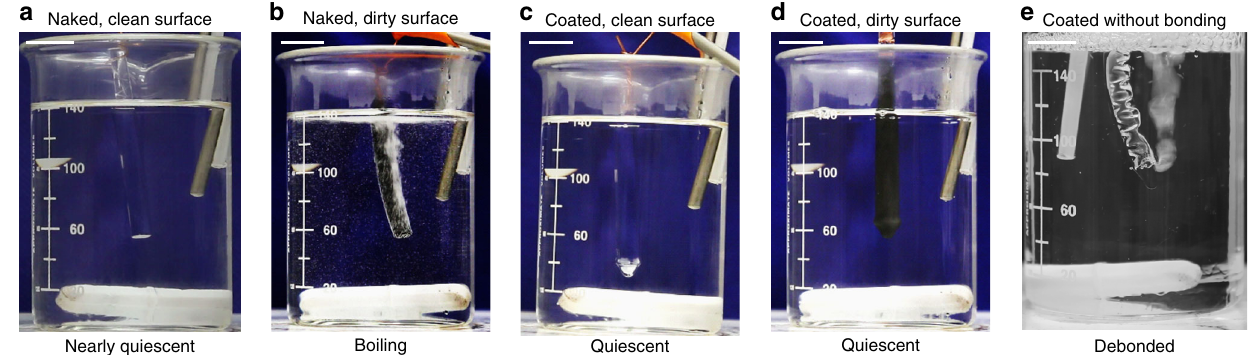
Fig. 9 Deep-frying hydrogels in mineral oil at 120 °C. a A hydrogel of a clean surface remains nearly quiescent, except for a stream of bubbles emitting from a defect site. b When graphite powders are spread on the surface of a naked hydrogel, water vapor bubbles off from the entire surface. c , d Elastomer- coated hydrogels remain quiescent with or without graphite particles on the external surface. e If the elastomer is not silane modi fi ed, vapor bubbles easily nucleate underneath the coating, blow up the coating, and dehydrate the hydrogel. The scale bar is 2 cm